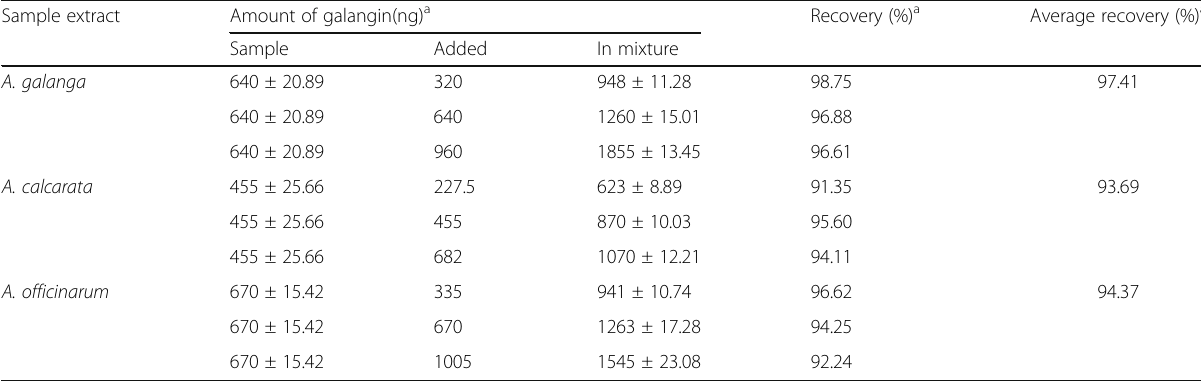
Table 3 Accuracy of the method for galangin Sample